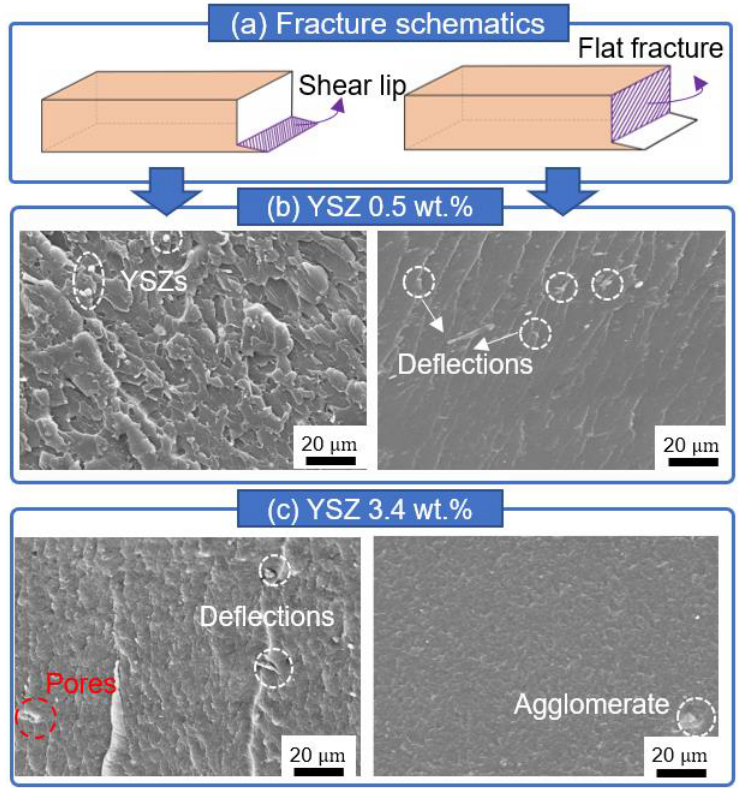
Figure 8. Representative SEM images of YSZ-added specimens after the three-point bending test: ( a ) Schematic illustration shows that a typical fracture mode of YSZ-added specimens consists of both shear lip and flat fracture. ( b ) Fracture surface of the 0.5 wt.% YSZ-added specimen contains smaller dimples than that of pure resin and white YSZ particles, deflecting crack propagation. ( c ) SEM images of the 3.4 wt.% YSZ specimen shows pores and agglomerates harmful to mechanical strength. Typical SEM images of 0.5 and 3.4 wt.% added YSZ are shown in Figure 8b,c, respec- tively. More dimples can be observed on the shear lip region of the 0.5 wt.% YSZ